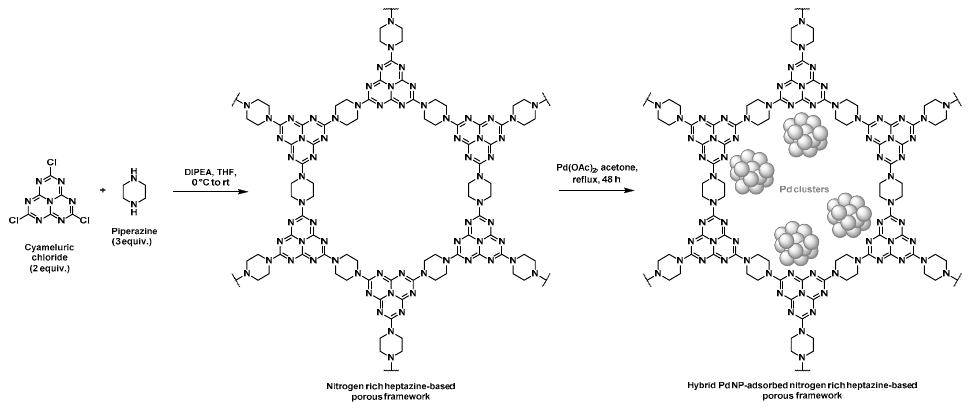
Figure 2. Synthetic pathway for the preparation of hybrid materials based on nitrogen rich heptazine-derived porous polymers and Pd NPs [42,43]. derived porous polymers and Pd NPs